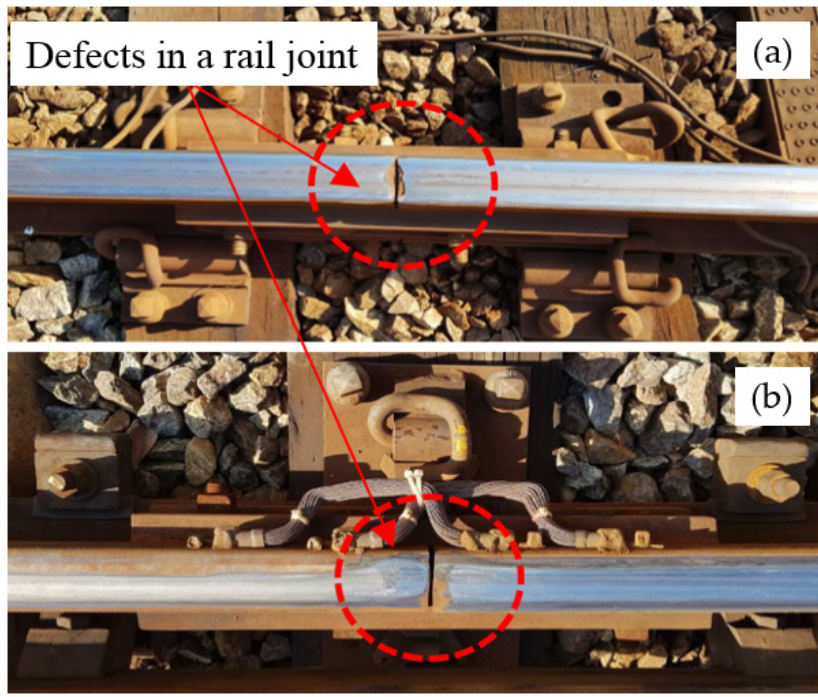
Figure 1. Photograph of typical defects by rail joint type. ( a ) Suspended joint; ( b ) supported joint.